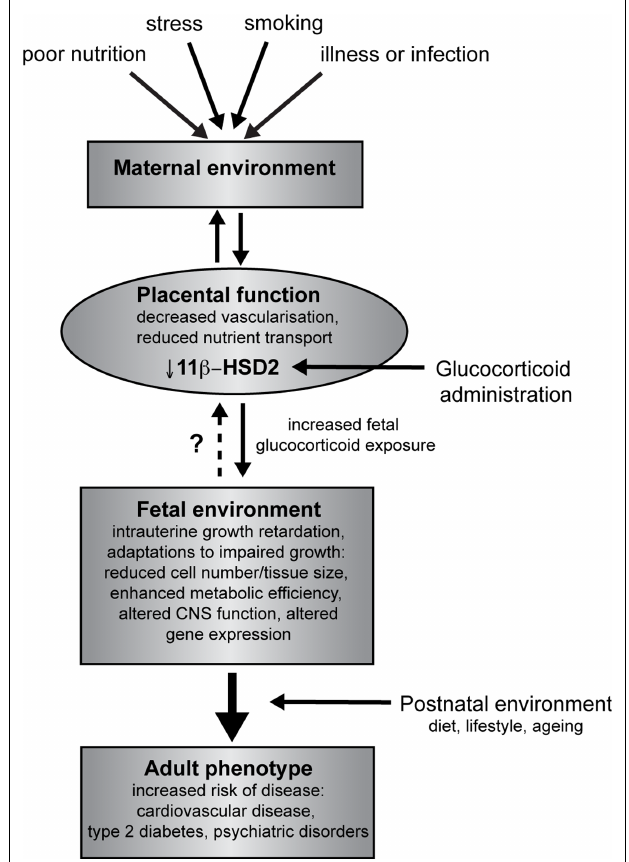
FIGURE 1 | Overview of developmental programming. A perturbed maternal environment, due to poor diet, excessive stress or impaired health during pregnancy, impairs placental function and thus delivery of nutrients (critically glucose and oxygen) to the fetus. In addition, administration of exogenous glucocorticoids reduces the activity of placental 11 β -HSD2, decreasing this barrier to excess glucocorticoids and reducing fetal growth. In response to these stressors, the developing fetus is able to adapt to the prevailing conditions in order to promote survival, altering tissue size, structure and function. These adaptations, although benefi cial in the short term, when confl icted by postnatal conditions predispose to an increased risk of adult